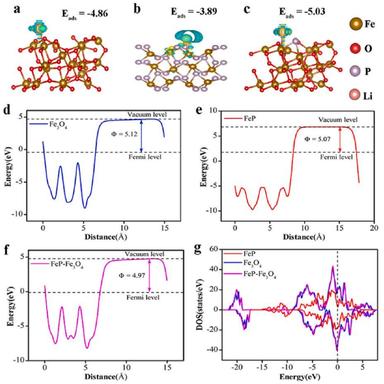
DFT calculations for Li adsorption on the Fe site of (a) Fe3O4, (b) FeP, and (c) FeP-Fe3O4. Yellow and cyan areas represent electron accumulation and depletion. Electrostatic potentials for (d) Fe3O4, (e) FeP, and (f) FeP-Fe3O4. (g) Density of states for the FeP, Fe3O4, and FeP-Fe3O4. (For interpretation of the references to colour in this figure legend, the reader is referred to the web version of this article.)